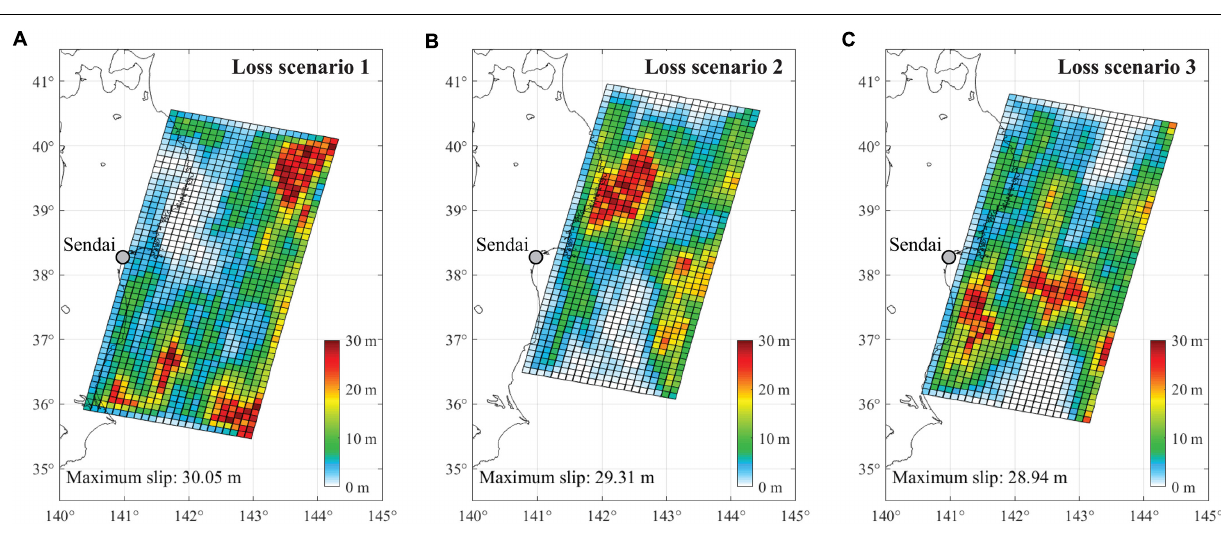
areas. The inundation results based on the 450-m resolution data are highly inconsistent with those based on finer resolutions in terms of inundation amplitude, spatial distribution, and inundation area. Figure 7 for the whole Sendai, PR1, and PR2. The EP